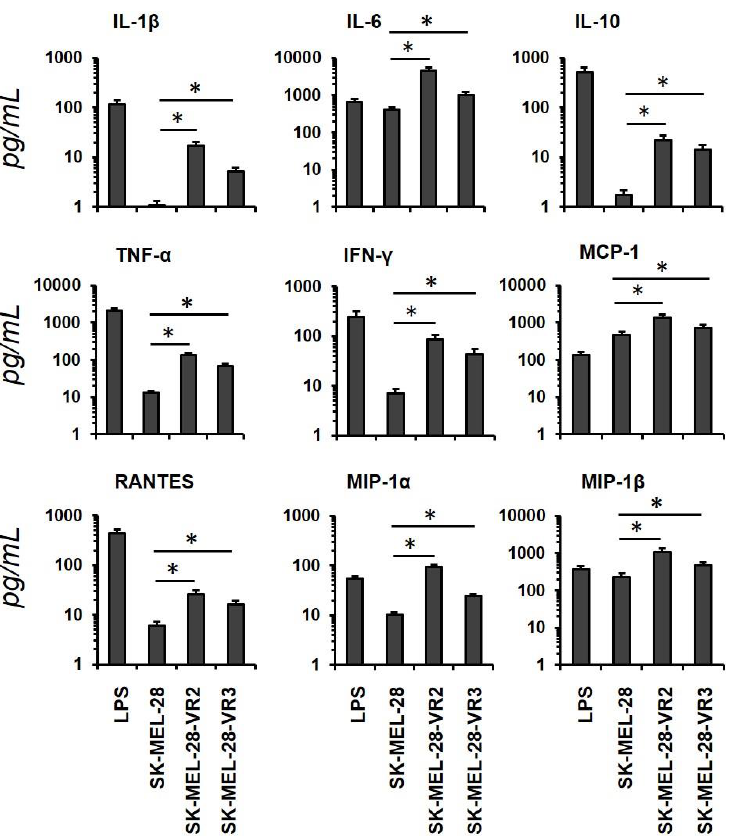
Figure 2. Analysis of cytokines and chemokines secreted by dendritic cells (DCs) incubated overnight with melanoma conditioned media (CM) or lipopolysaccharide (LPS). Concentrations of the indicated proteins in CM were quantified by multiplex immunoassay. Results are shown as mean ± SD of two experiments carried out in duplicate (statistical significance: * p < 0.01).